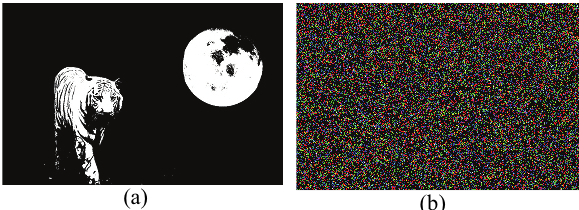
Fig. 12. (a) I2- Model image 2, (b) Ciphered image of the model image 2.